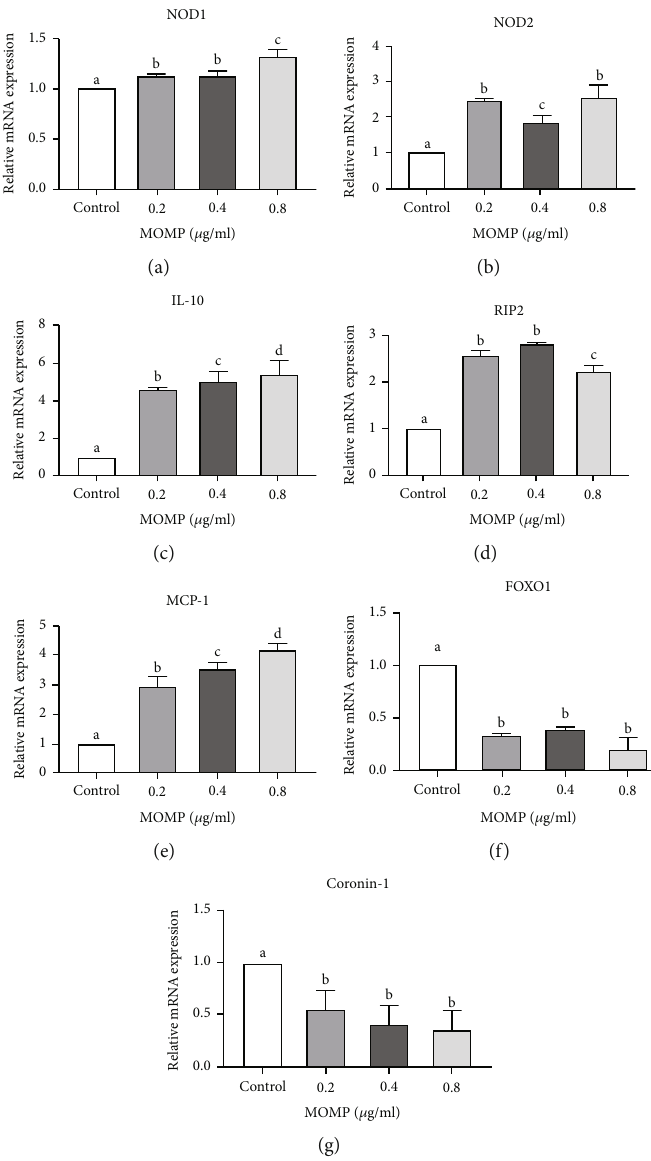
Figure 3: Analysis of mRNA expression of 7 proteins in RAW 264.7 treated with MOMP. The signi fi cant di ff erences in the expression of 7 proteins in groups treated with di ff erent concentrations were marked by the alphabetic notation (a, b, c, and d). In each detected expression of 7 proteins, if any two histograms with the same marking letter represented no signi fi cant di ff erence between two concentrations, any two histograms without the same marking letter represented a signi fi cant di ff erence. (a – g) Relative mRNA expression analysis of NOD1, NOD2, IL-10, RIP, MCP-1, FOXO1, and coronin-1 for 24h treated by di ff erent concentrations of MOMP. Control represented the cells cultured in a normal medium. 0.2 represented the cells cultured in the medium containing 0.2 μ g/ml MOMP, 0.4 represented the cells cultured in the medium containing 0.4 μ g/ml MOMP, and 0.8 represented the cells cultured in the medium containing 0.8 μ g/ml MOMP (error bars = SD